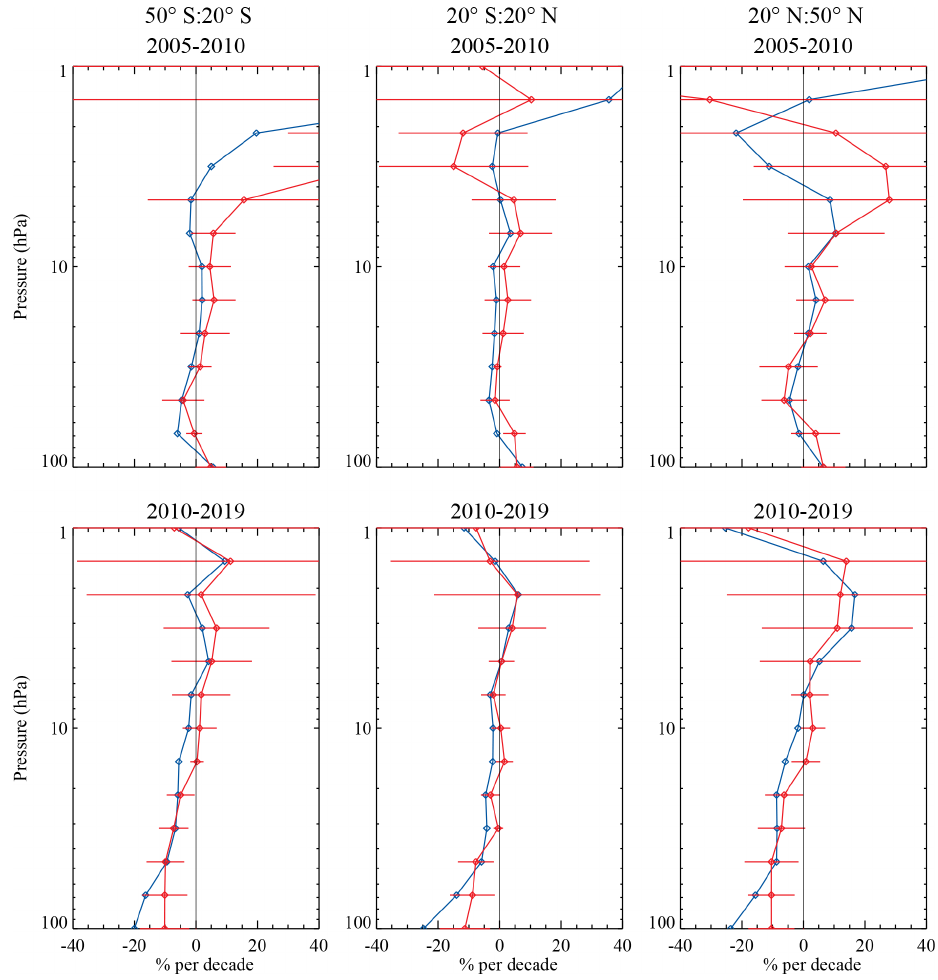
Figure 16. Figure 16 is the same as Fig. 14 but for N 2